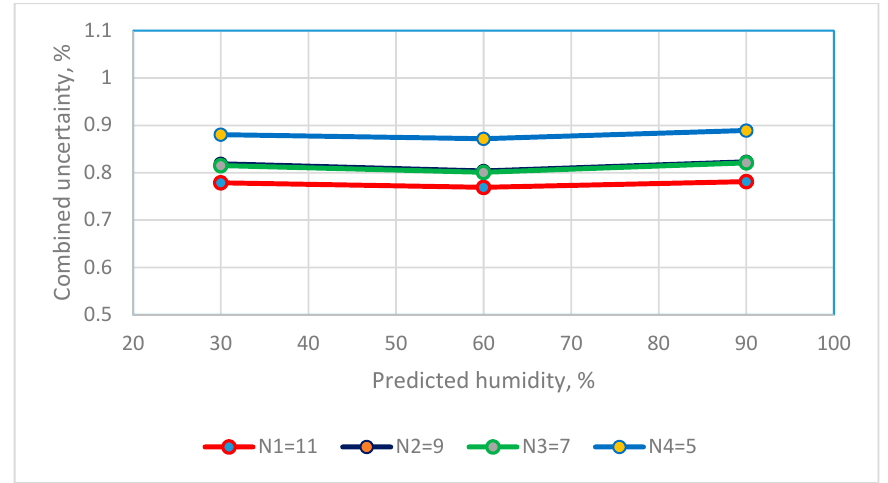
Figure 8. The distribution between numbers of saturated salt solutions and combined uncertainty of capacitance RH sensors.